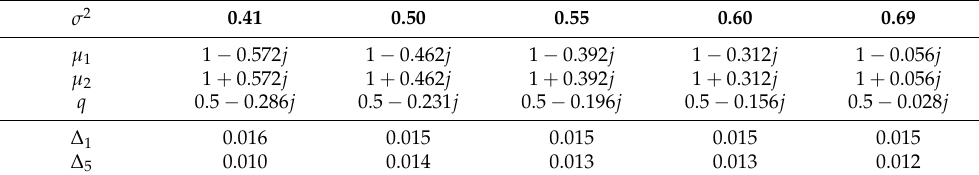
Table 4. Values of parameters µ 1 , µ 2 , and q of the hyperexponential approximation obtained for lognormal distribution function for values of its parameter 0.4 < σ 2 < 0.7, and corresponding Kolmogorov distances ∆ for the main result.